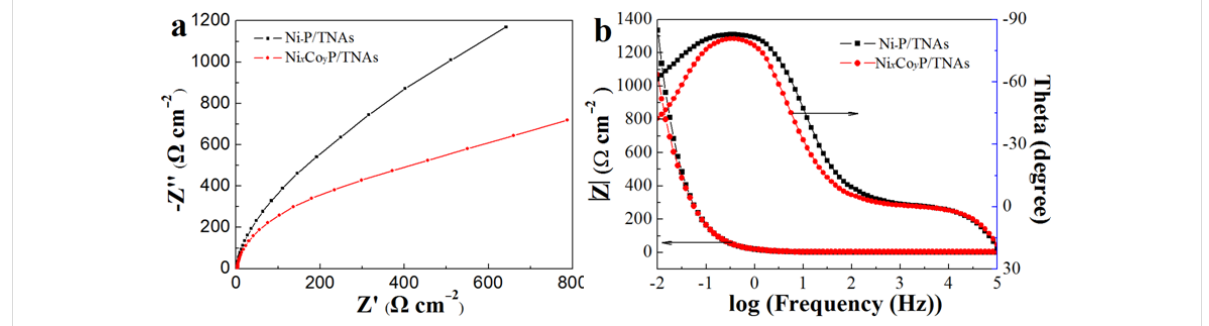
Figure 8: (a) Nyquist curves and (b) Bode plots of the samples.